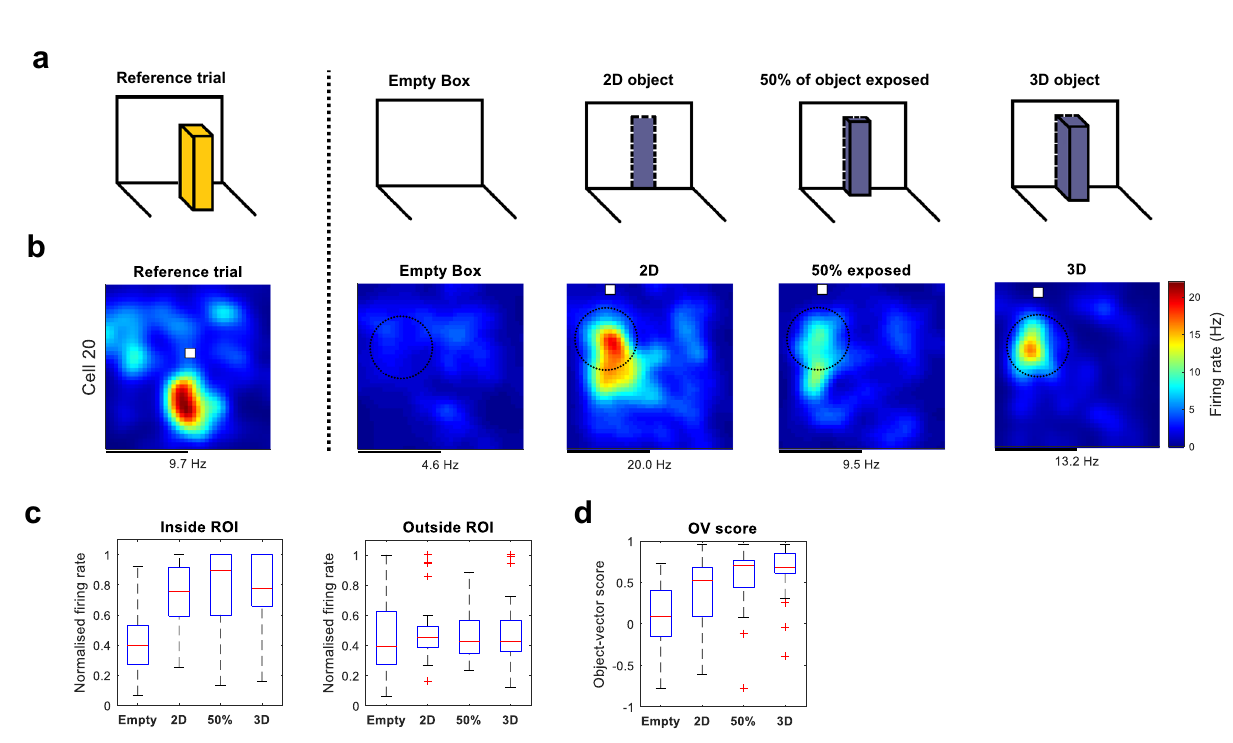
Fig. 2 Object-vector cells respond to two-dimensional objects. a Experimental design with four different trials: mice foraged in an environment with either an object absent ( ‘ Empty Box ’ ) or present ( ‘ 2D ’ , ’ 50% ’ , ‘ 3D ’ ). In the three object trials, we varied the amount of the object ’ s volume exposed to the animal. In the 2D trial, the visible part of the object was a fl at 2D surface, with the rest completely embedded into the wall. In the middle trial, the object was partially embedded into the wall so that 50% of its volume was exposed. In the 3D trial, the full volume of the object was exposed. The reference trial, used to fi nd the cell ’ s vector coordinates, is shown on the left. This was the original ‘ Object ’ trial used to identify the cell as an OV cell (Fig. 1a, middle). b Colour- coded rate maps from example OV cell that responded as strongly to 2D surfaces as to 3D objects. Rate maps show colour-coded fi ring rate in Hz as a function of the animal ’ s position. The white square marks the object location. The dotted circle marks the ROI in which we expected the cell to fi re based on its vector coordinates. The vector coordinates of the cell were found by applying the algorithm from Supplementary Fig. 3 to the ‘ Reference trial ’ on the left. This trial is also what we used as a template for computing the OV score. Peak fi ring rate (Hz) is indicated below each map. Scale bar, 40 cm. c Box-and- whisker plots of normalised fi ring rates (Hz) of object-vector cells ( n = 30) as a function of object dimensionality. Firing rates were normalised to the maximum data point across all eight data points observed for each cell (4 experimental conditions × inside/outside ROI) so that the maximum rate is 1. The middle line (in red) on each box indicates the median, while the bottom and top lines (in blue) indicate the lower and upper quartiles, respectively. Whiskers show the range of data in each condition. Red crosses show outliers that lie more than 1.5 times outside the interquartile range. The fi ring rate was measured either inside (left) or outside the ROI (right). d Box-and-whisker plot of object-vector scores (ranging from − 1 to 1) as a function of object dimensionality. The object-vector score is equivalent to the Pearson correlation between pairs of object-centred rate maps (see 'Method' for details). Here, the reference rate map is from the ‘ Object ’ trial originally used to identify the